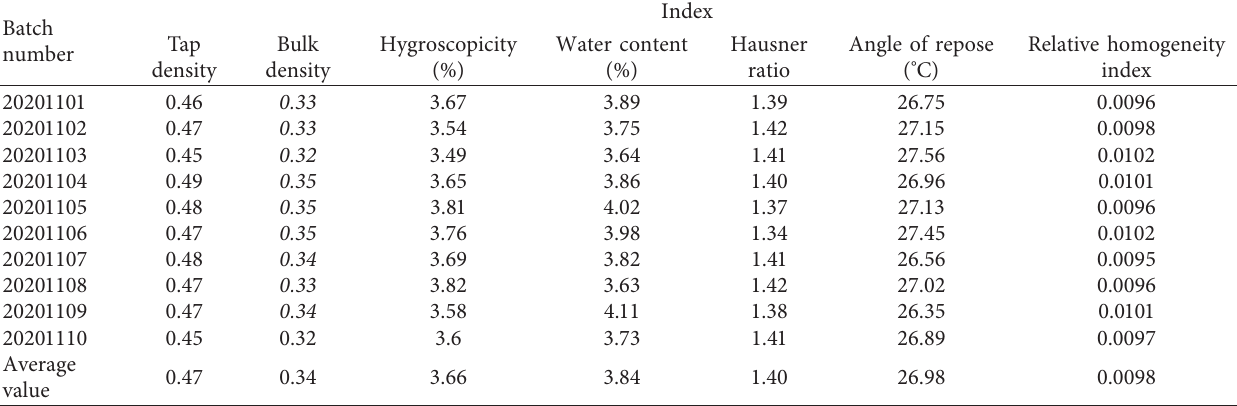
Table 6: The physical evaluation index results of ten batches of granules ( n � 10).